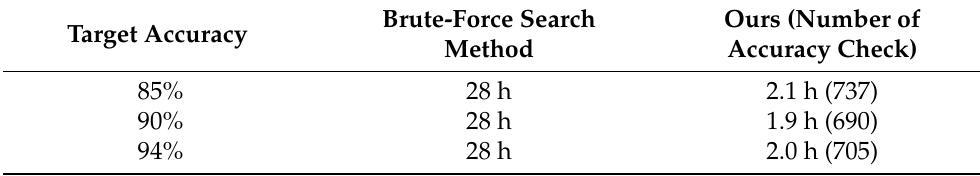
Table 10. The execution times in the corresponding accuracies derived from the proposed method and the individual cases of network slimming and deep compression for DenseNet-121.